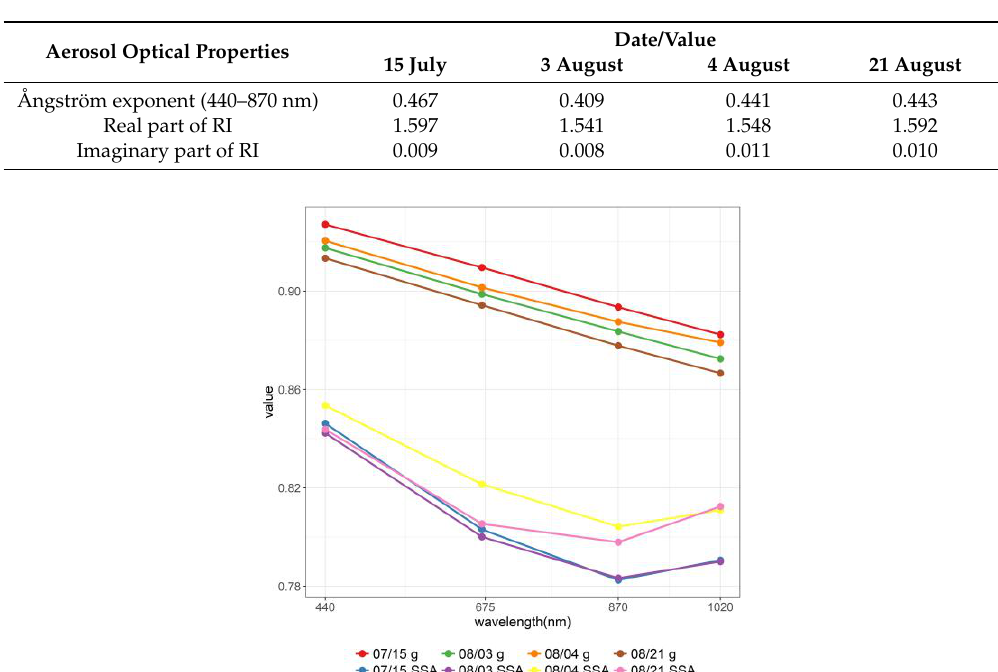
Table 5. Calculation results of aerosol parameters of the Ångström exponent and complex refractive index.